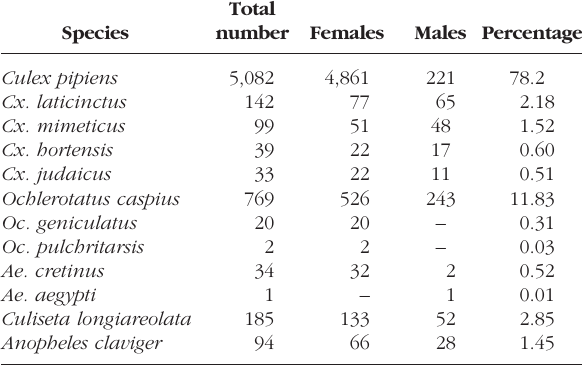
Table I. – Total number and percentages of the 12 mosquito spe- cies collected in Lebanon during 1999-2001.